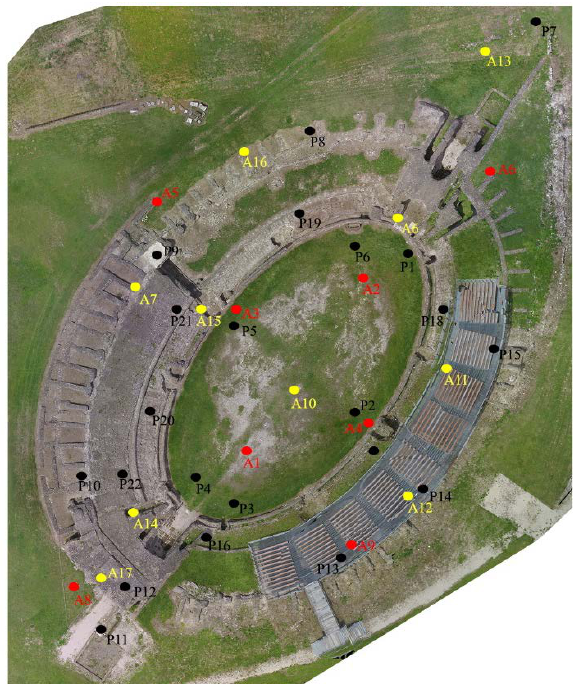
Figure 5: GCP in two different modalities: black (nRTK measurement on target), red (fast-static measurement on natural points), and yellow (nRTK measurement on natural points).